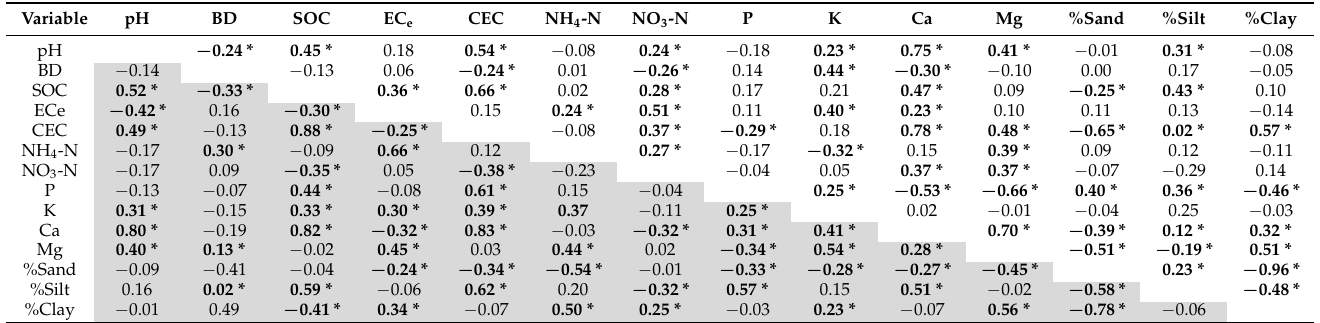
Table 2. Pearson’s correlation matrix of soil properties in terraced paddy field samples ( n = 72, white background) and upland rice ( n = 75, grey background).